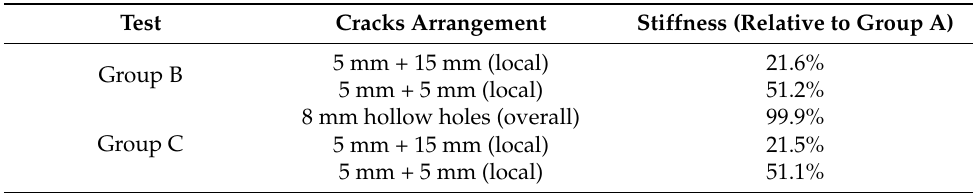
Figure 1. B ( left ) quality grade and C ( right ) quality grade pile (unit: cm). Table 2. Model pile stiffness reduction (relative to group